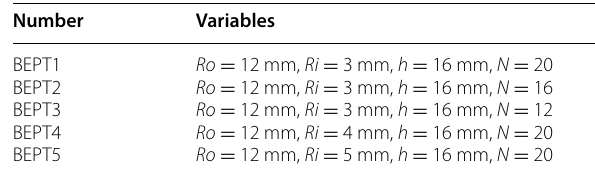
Table 1 Main Parameters of each kind of